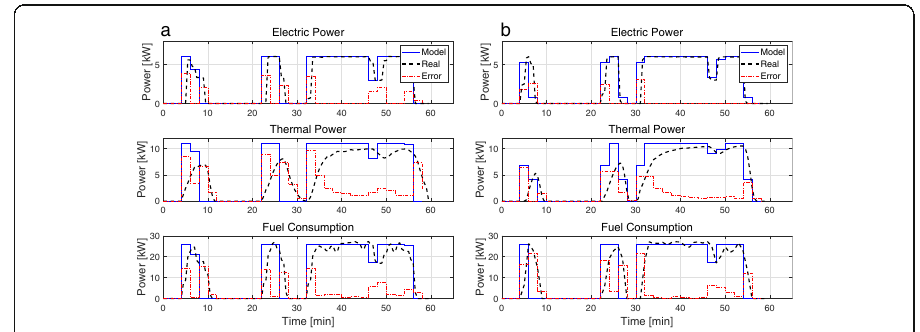
Fig. 2 Experimental results by executing the reference model Steck, 2012 ( a ) and the presented model ( b ). “ Model ” defines the predicted output of the CHP unit by the operational strategy of the mathematical model. “ Real ” is the actual reached power of the real CHP unit in the field test. The error defines the absolute mean deviation within each time